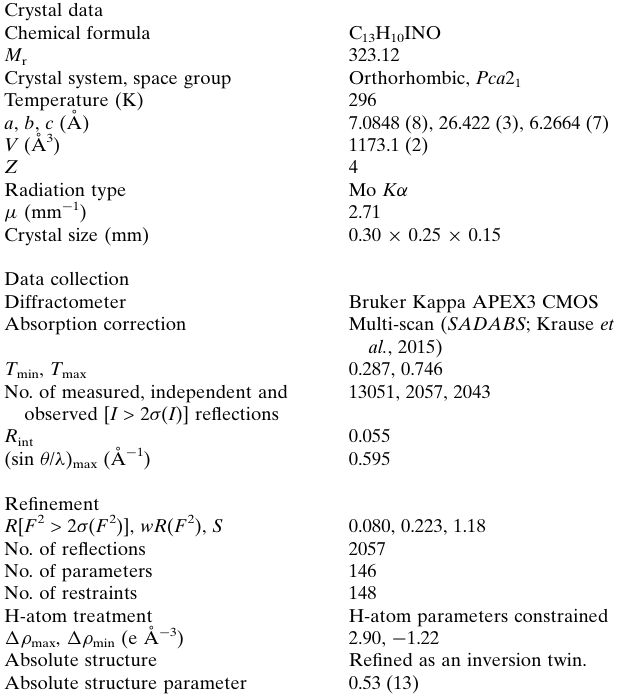
Table 2 Experimental details.